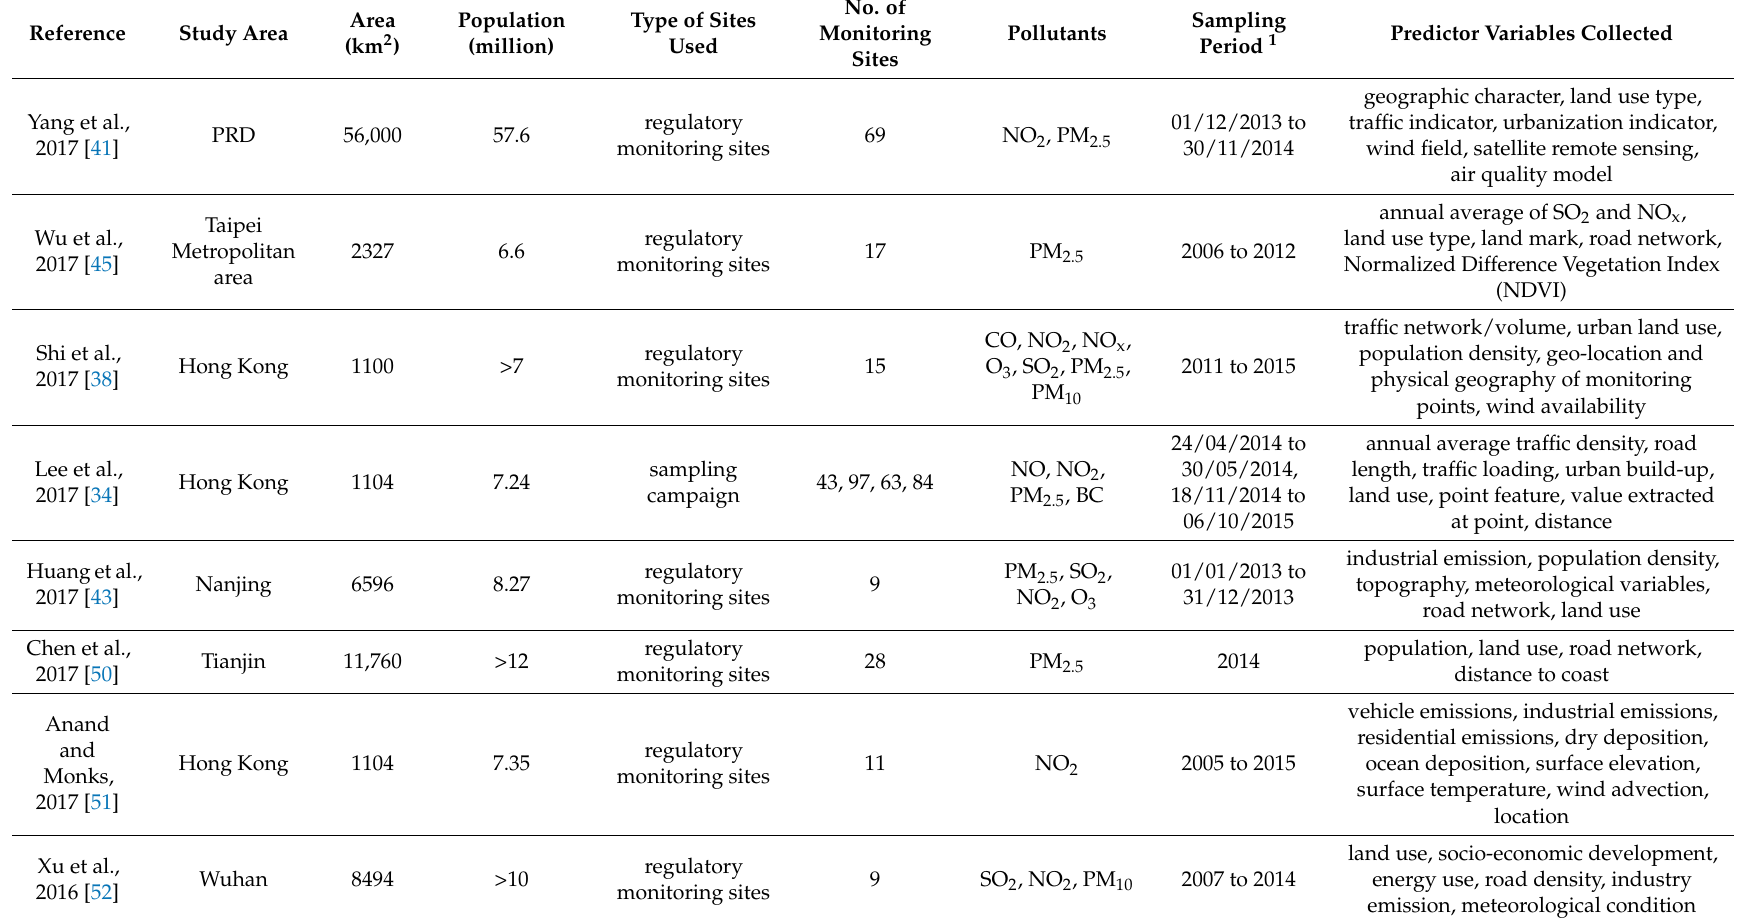
Table 3. Characteristics of recent air pollution land-use regression studies in China that include NO 2 or PM 2.5 /PM 10 as a modelled